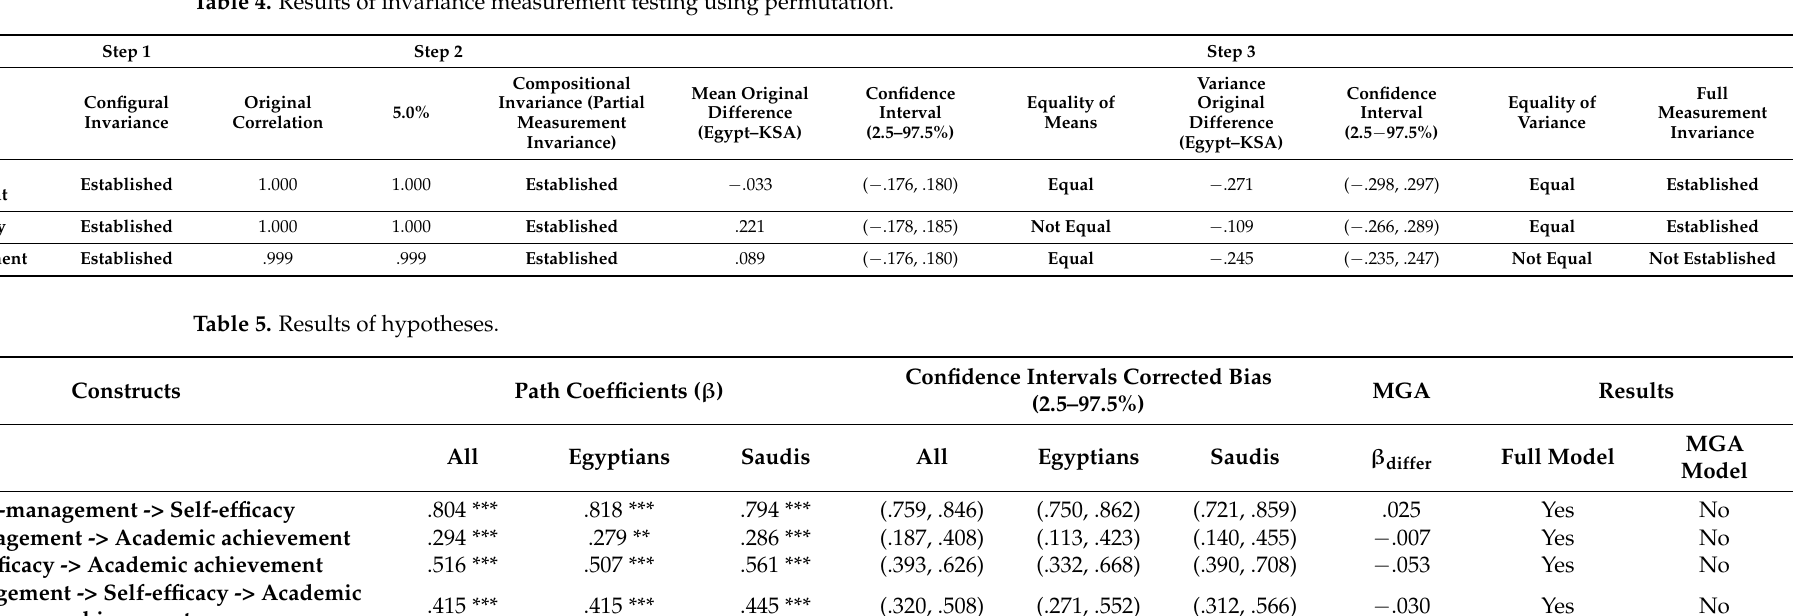
Table 4. Results of invariance measurement testing using permutation.